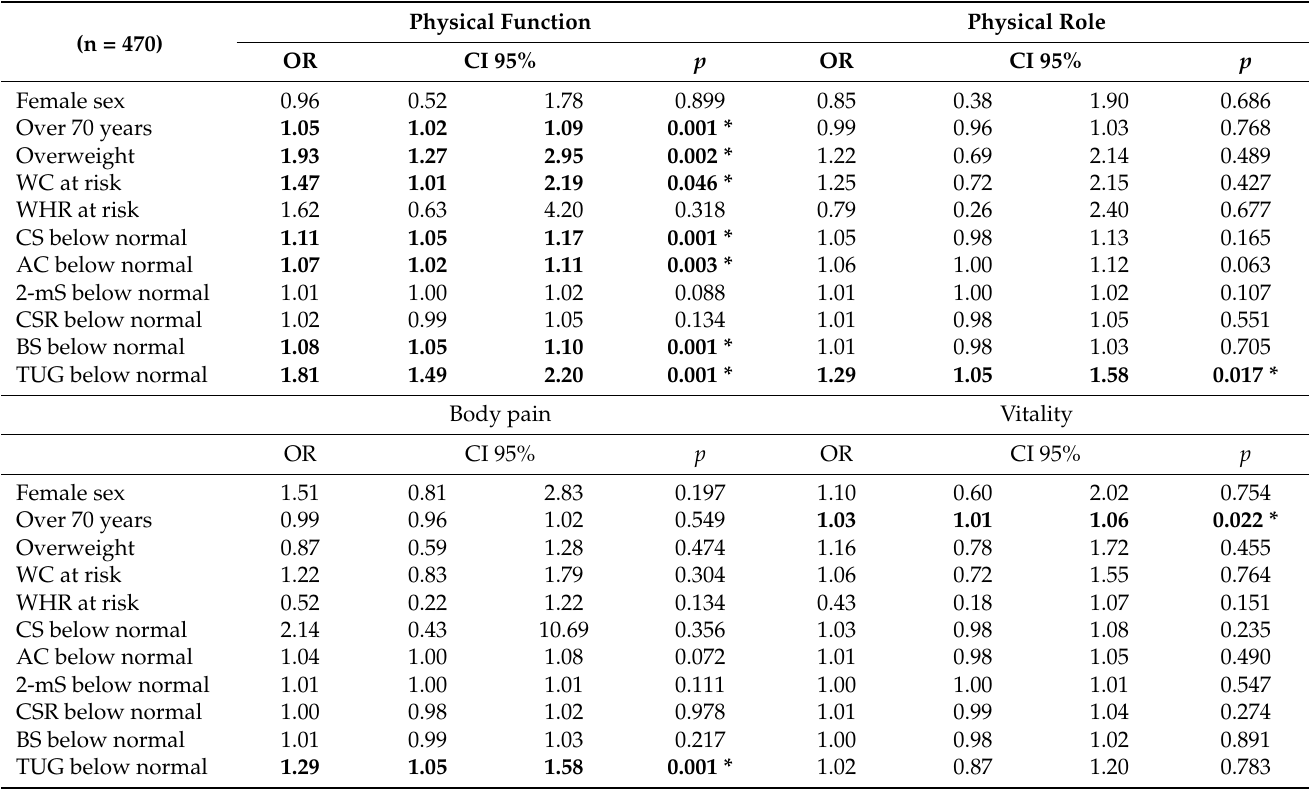
Table 2. Factors associated with a low HRQoL in physical function, physical role, body pain, and vitality dimensions.